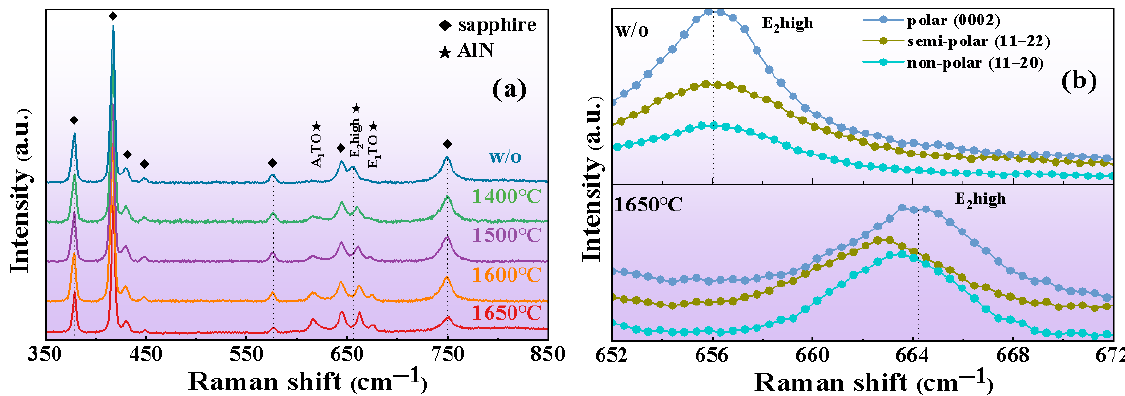
Figure 6. ( a ) Raman spectra of the non-polar film without and with annealing. ( b ) Raman spectra of polar, semi-polar and non-polar films without and with annealing at 1650